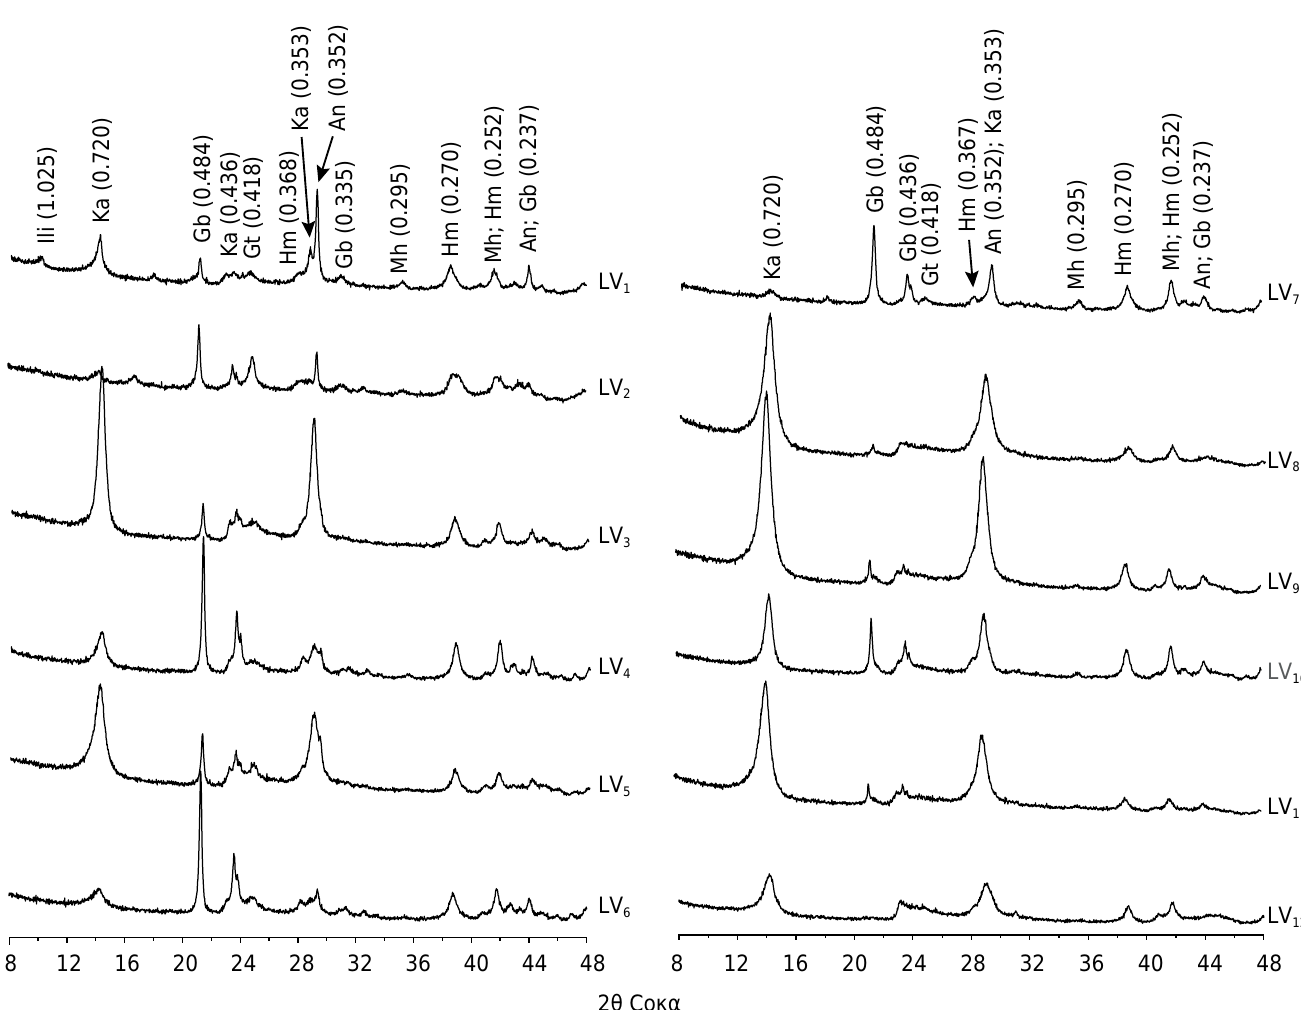
Figure 4. X-ray patterns from clay fraction (oriented slides) of the soils. Ka: kaolinite; Gb: gibbsite; Qz: quartz; An: anatase; Hm: hematite; Gt: goethite; Mh: maghemite; and Ili: illite. Numbers between parentheses correspond to distance between adjacent planes in nanometers (nm) expressed in three decimal places. LV 1 , LV 3 , LV 4 , LV 5 , LV 6 , LV 8 , LV 9 , LV 10 , and LV 11 : Rhodic Hapludox; LV 2 ,